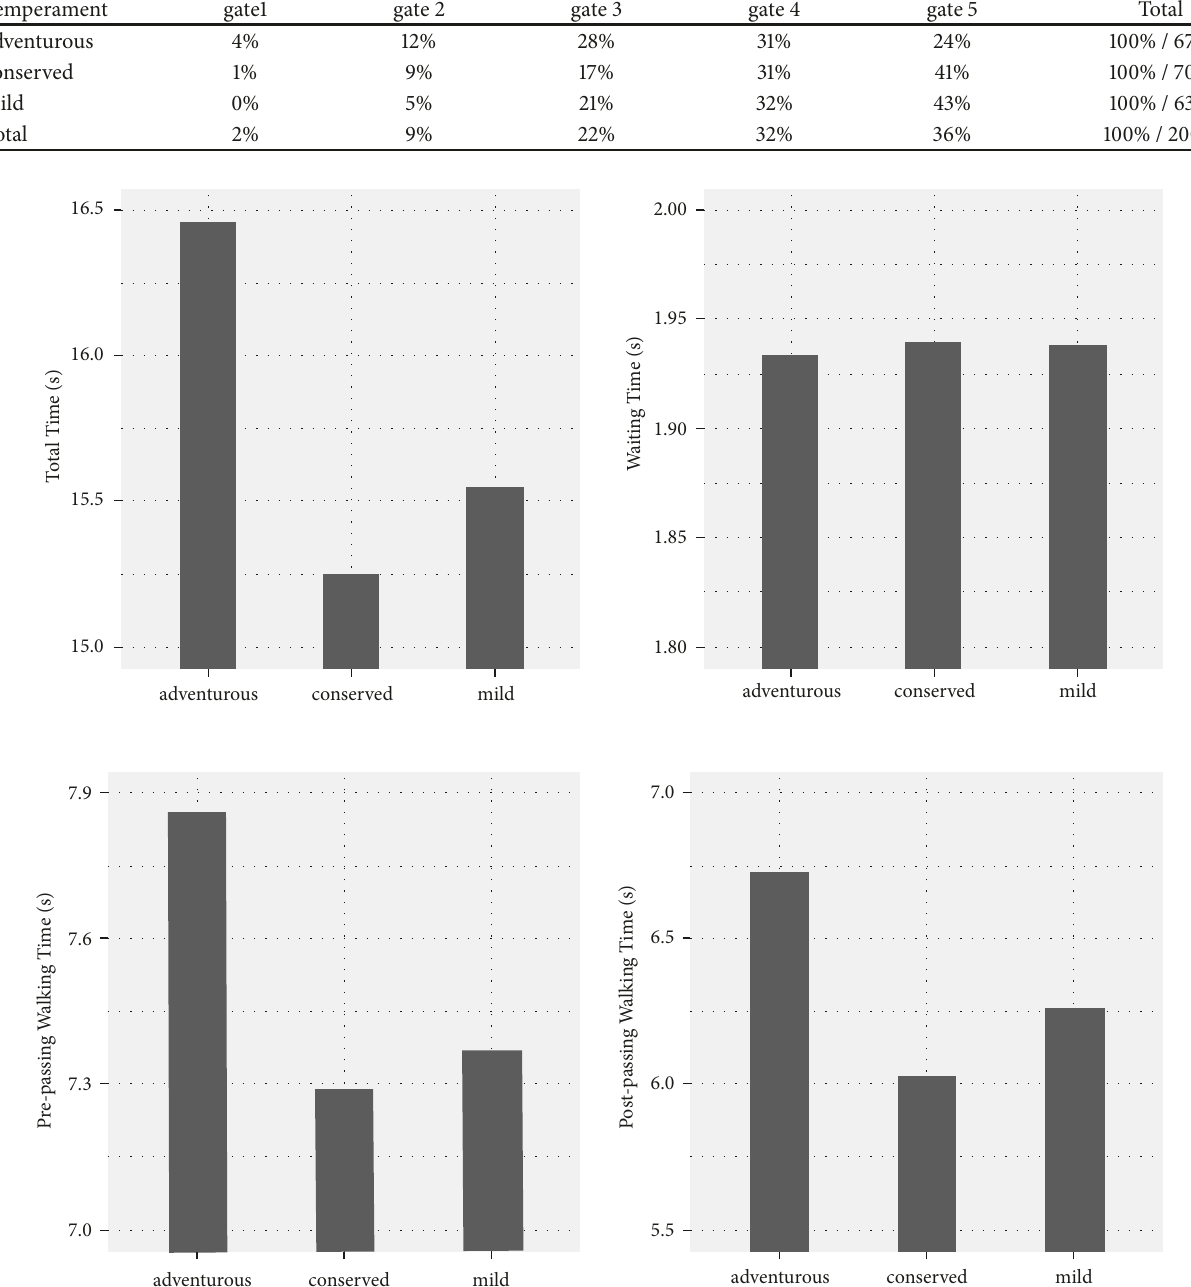
Figure 12: The passing times for different